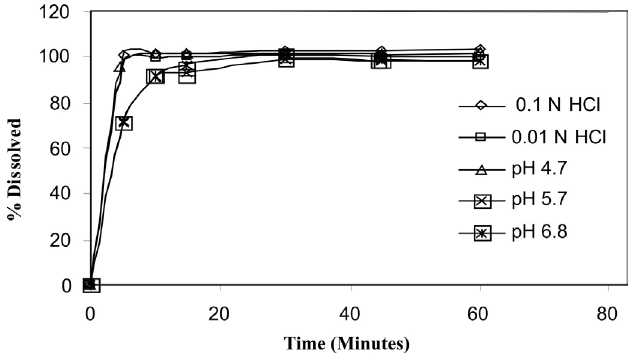
FIGURE 2 - Dissolution profile of Product A in different media at 5, 10, 15, 30, 45 and 60 minutes.